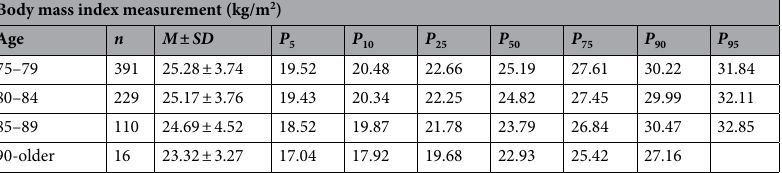
Table 2. Percentile distribution of various physical fitness test results of community-dwelling older adults. *A negative score indicates that the fingertip does not pass the 0 mark. **A negative score indicates that the fingertips do not